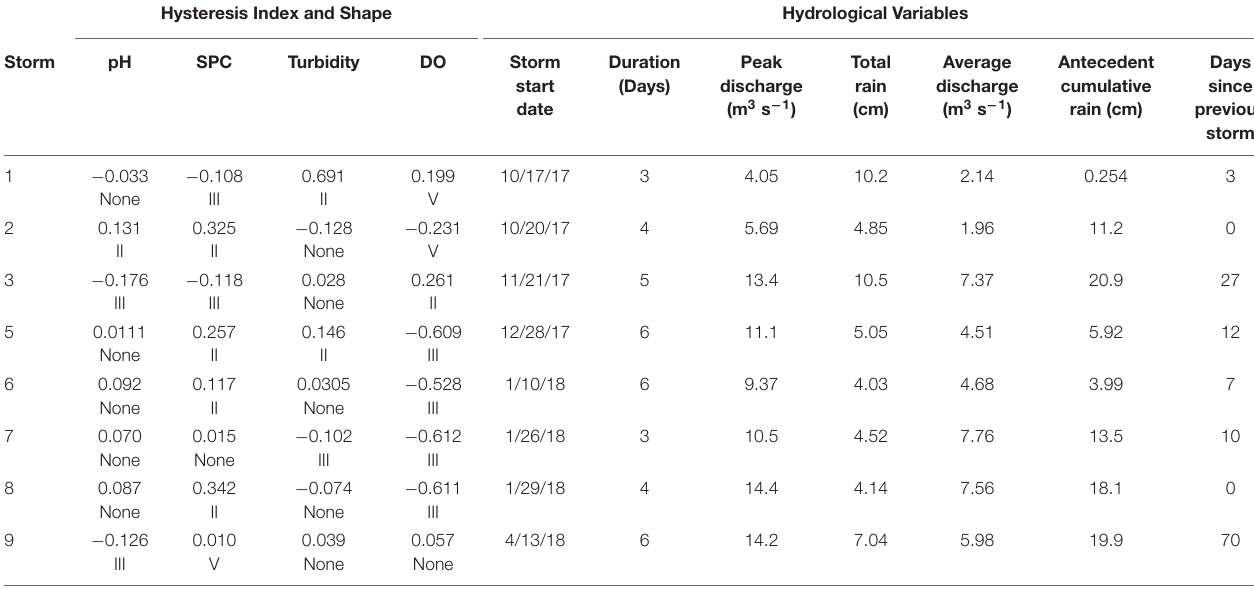
TABLE 2 | Hysteresis Index and hysteresis shape for pH, specific conductivity (SPC), and turbidity and hydrological variables for each